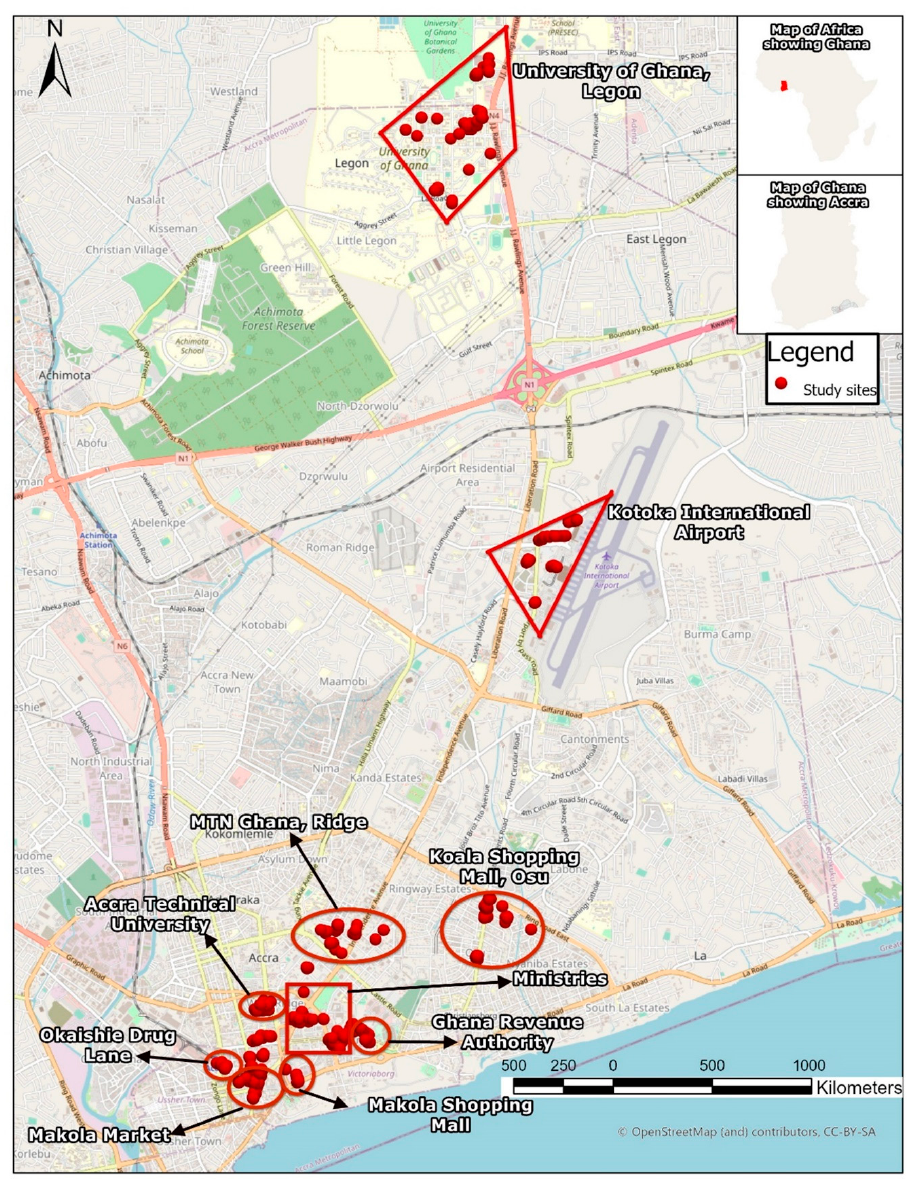
Figure 1. An annotated map of study sites in Accra.